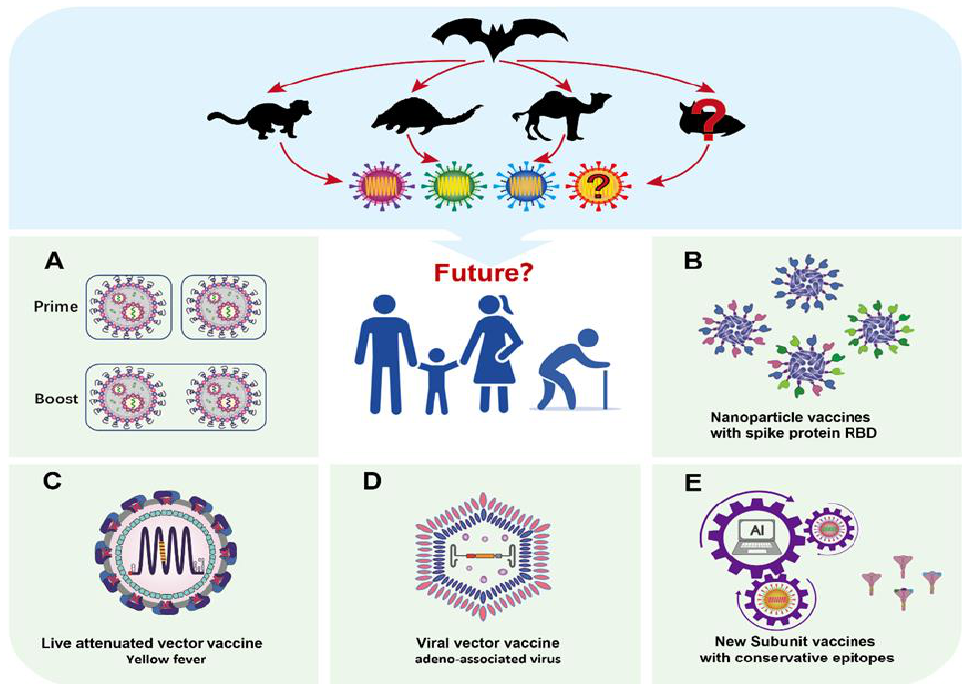
Figure 3. Applied platform for next-generation anti-coronavirus R&D. Booster immunization with approved vaccines ( A ), Vaccines with more complex sources of spike protein RBD ( B ), Live attenuated viral vaccine delivered SARS-CoV-2 antigen ( C ), Subunit vaccines with T-cell epitopes ( D ). More cutting-edge vaccine design using AI technology ( E ) can be used for the prevention of infectious diseases.